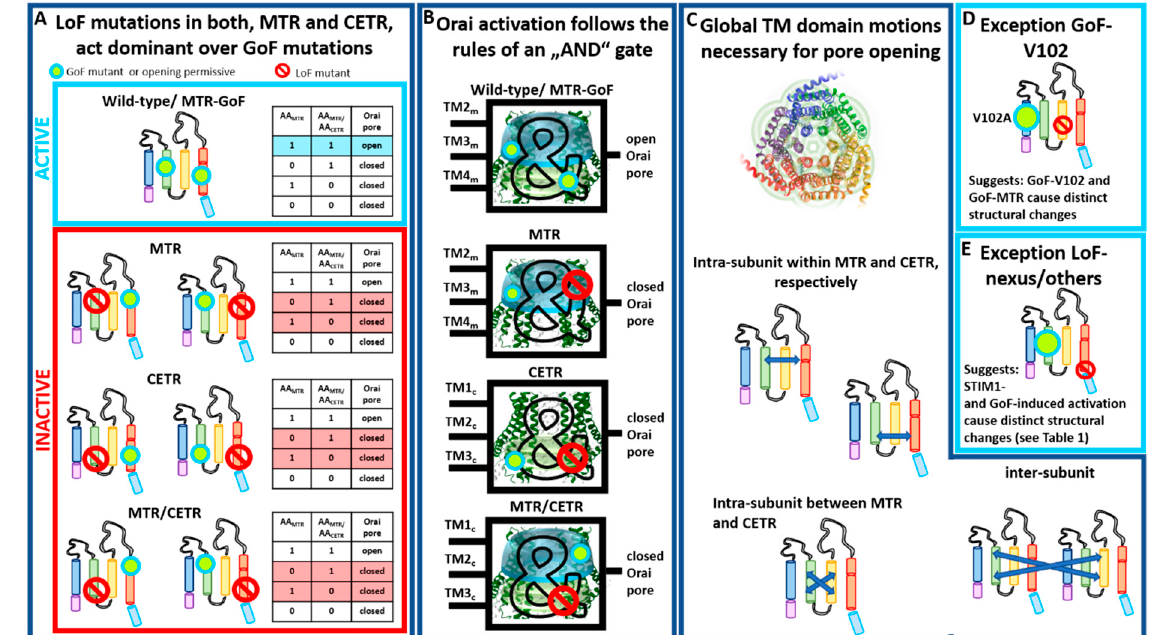
Figure 5. Global conformational changes in the Orai complex are indispensable for pore opening. A series of gating checkpoints need to capture an opening-permissive conformation to achieve an activation of Orai pore. Our library of double mutants [82] always revealed a dominant effect of the LoF mutation. ( A ) This suggests that, as soon as one of the multiple checkpoints in the Orai channels is defective (not in an opening-permissive conformation), the Orai channel cannot be activated. This behavior can be compared or even described with the rules of the Boolean relations. They are typically used in digital electronics, and one of those relations is the AND gate. The AND gate is an operator that connects two or more inputs with one output. As long as all inputs are 1, the output is also 1. As soon as one of the inputs is 0, then the output is also 0. These relations can be nicely used to describe the dependence of Orai1 gating checkpoints with Orai1 pore opening (individual tables in ( B )). Only as long as all checkpoints in the MTR are 1 can the pore open. This holds also for the CETR. Thus, both MTR and CETR can be viewed as two individual AND gates. ( B ) Nevertheless, they can also be combined and, overall, all inputs (checkpoints) from MTR and CETR together can be viewed as an AND gate ( B ). ( C ) Global motions leading to Orai1 pore opening can be visualized as spherically propagating waves with the activation signal either from a constitutively active mutation or from STIM1 coupling to the Orai1 C-terminus (C, top ). Not only intra-subunit interactions within MTR and CETR, but also between MTR and CETR from two different planes impact each subunit ( C , middle, bottom ). Additional inter-subunit interactions across membrane planes (MTR and CETR) of adjacent subunits influence the entire Orai1 channel complex. Within our screen, two exceptions were discovered (GoF V102 and LoF nexus), whose behavior is visualized and described in the right top ( D ) and right middle panel ( E ).